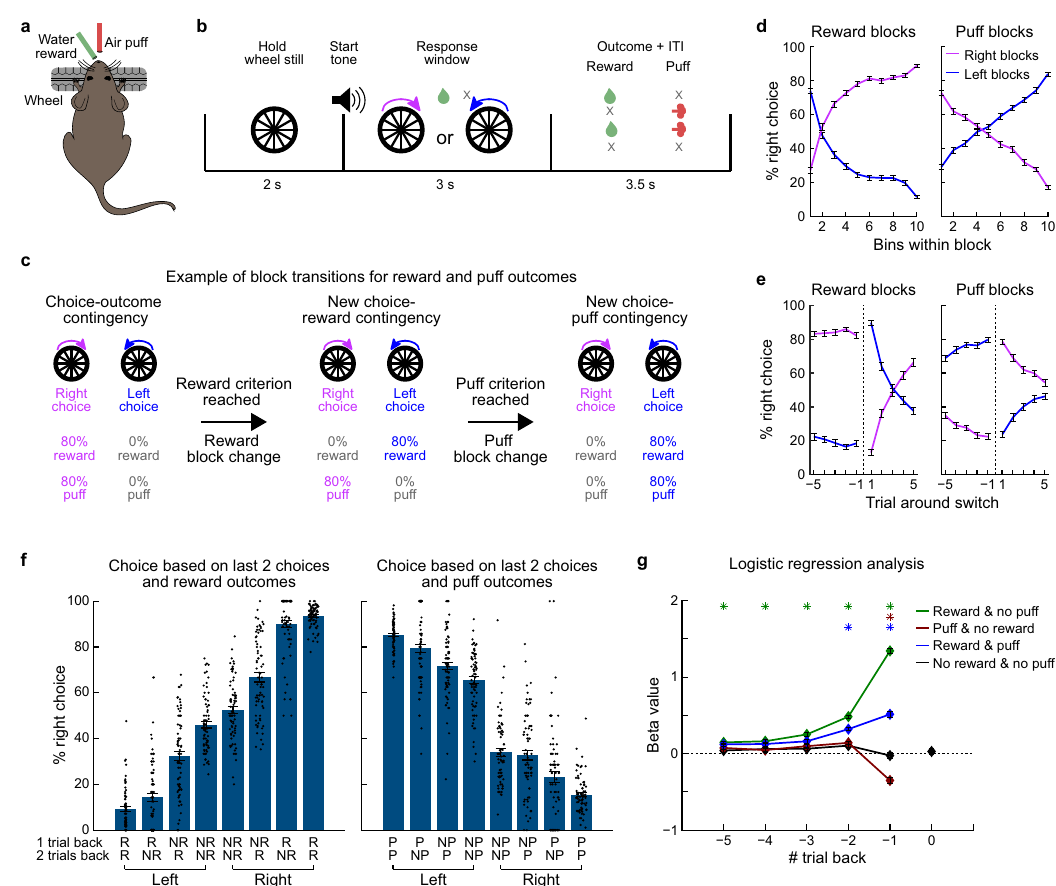
Fig. 1 The cost-bene fi t bandit task. a Behavioral setup. Head- fi xed mice reported choices by rotating a wheel to the left or the right. Water rewards and air puffs were delivered via two tubes. b Trial procedure. Mice initiated trials by holding the wheel still for 2 s. An auditory go-cue signaled trial start, after which the mouse had 3 s to move the wheel 15° in either direction. Left and right actions were probabilistically linked to reward and air puff delivery, giving four possible outcome combinations: reward-no puff, puff-no reward, reward-puff, and no reward-no puff. c Action – reward and action – puff contingencies changed in block of trials independently of each other. d Choices within the reward and puff blocks. Trials within blocks were grouped into 10 bins. Error bars show SEM across sessions ( n = 75 sessions from 13 mice). e Behavioral adaption during fi ve trials before and after reward and puff block switches (mean ± SEM, n = 75 sessions). f Mouse decisions were affected by the outcomes and actions in the last two trials (mean ± SEM, n = 75 sessions). For simplicity, only trials in which the mouse made the same action in the last two trials were included (R, reward; NR, no reward; P, puff; NP, no puff). Trials in which the mouse did not make the same response in the last two trials were omitted. g Regression coef fi cients (mean ± SEM) for the 4 types of outcomes (reward/no puff, puff/no reward, reward/puff, and no reward/no puff) for the preceding fi ve trials, as calculated using an auto-regressive model (reward, no puff: − 1: p = 1e − 47, − 2: p = 1e − 19, − 3: p = 1e − 6, − 4: p = 0.0065, − 5: p = 0.0018; puff, no reward: − 1: p = 1e − 8; reward and puff: − 1: p = 1e − 17, − 2: p = 1e − 6; n = 13 mice, two-sided t-test comparing the beta values of reward, puff and both outcomes with no outcome, * p < 0.05). Source data are provided as a Source Data fi le.